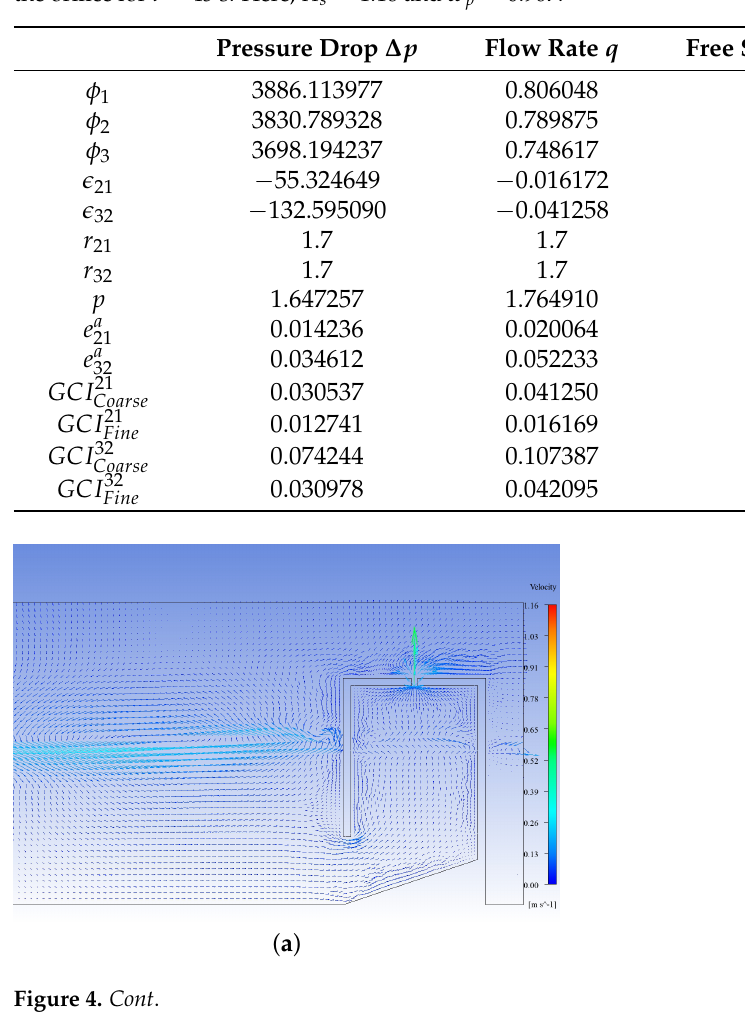
Table 1. Discretization errors of numerical solutions. These data were collected at the mid-point of the orifice for t = 45 s. Here, H s = 1.18 and ω p = 0.967.